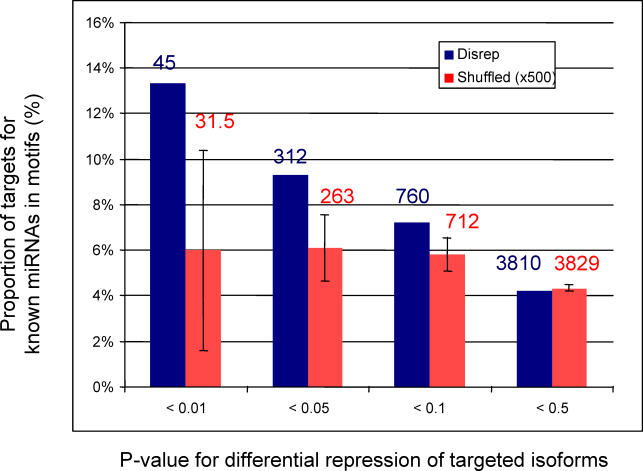
Proportions of Targets for Known miRNAs among Predictions Obtained at Different p-Value Ranges by the Disrep ProcedureNumbers on top of bars give total sample size for this p-value range. Values are cumulative. Blue: test dataset; red: average of 500 shuffled controls (see text). Error bars provide standard deviation.